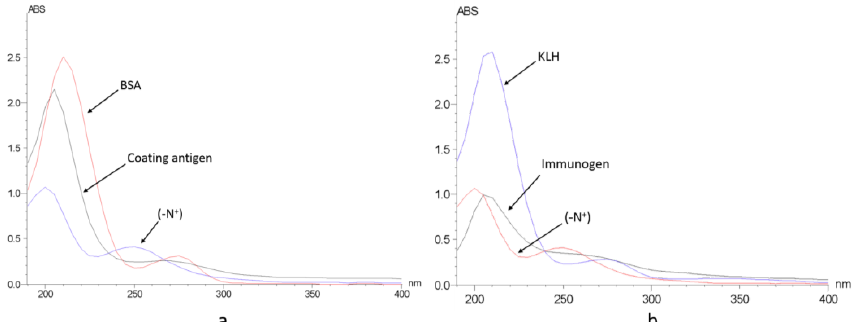
Figure 3. UV spectrum of the designed hapten (–N+), protein and complete antigen. ( a ) BSA as protein; ( b ) KLH as protein.